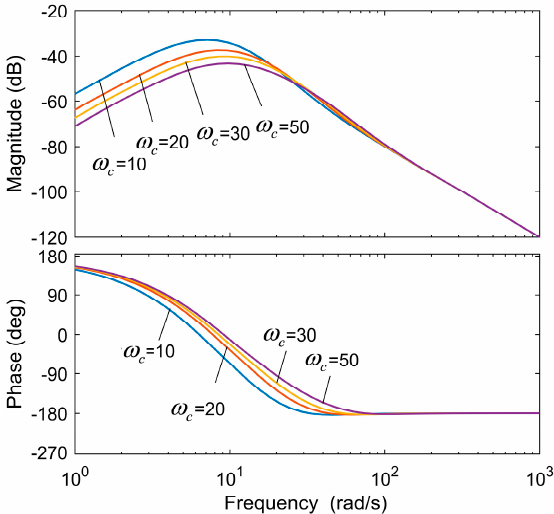
Energies 2019 , 12 , x FOR PEER REVIEW 14 of 23 Figure 11. Frequency domain characteristic curve of perturbation transfer function (when ω c changing).